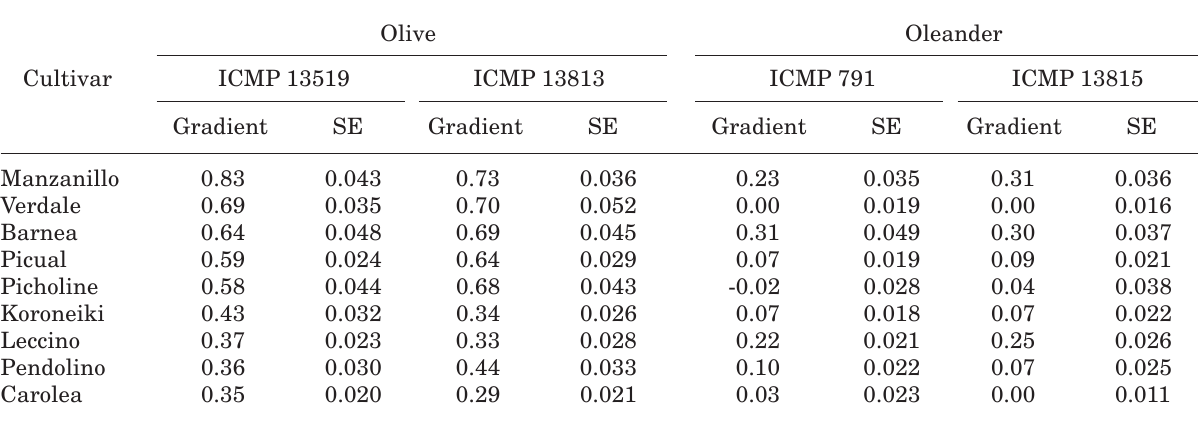
Table 3. Gradients representing reactions of nine olive cultivars inoculated with P. savastanoi olive knot strains ICMP 13519 and 13813 and oleander knot strains ICMP 791 and 13815 recorded after 2 months. Values are ex- pressed as change in gall diameter / ten-fold change in inoculum concentration. Mean gradients with their standard errors are